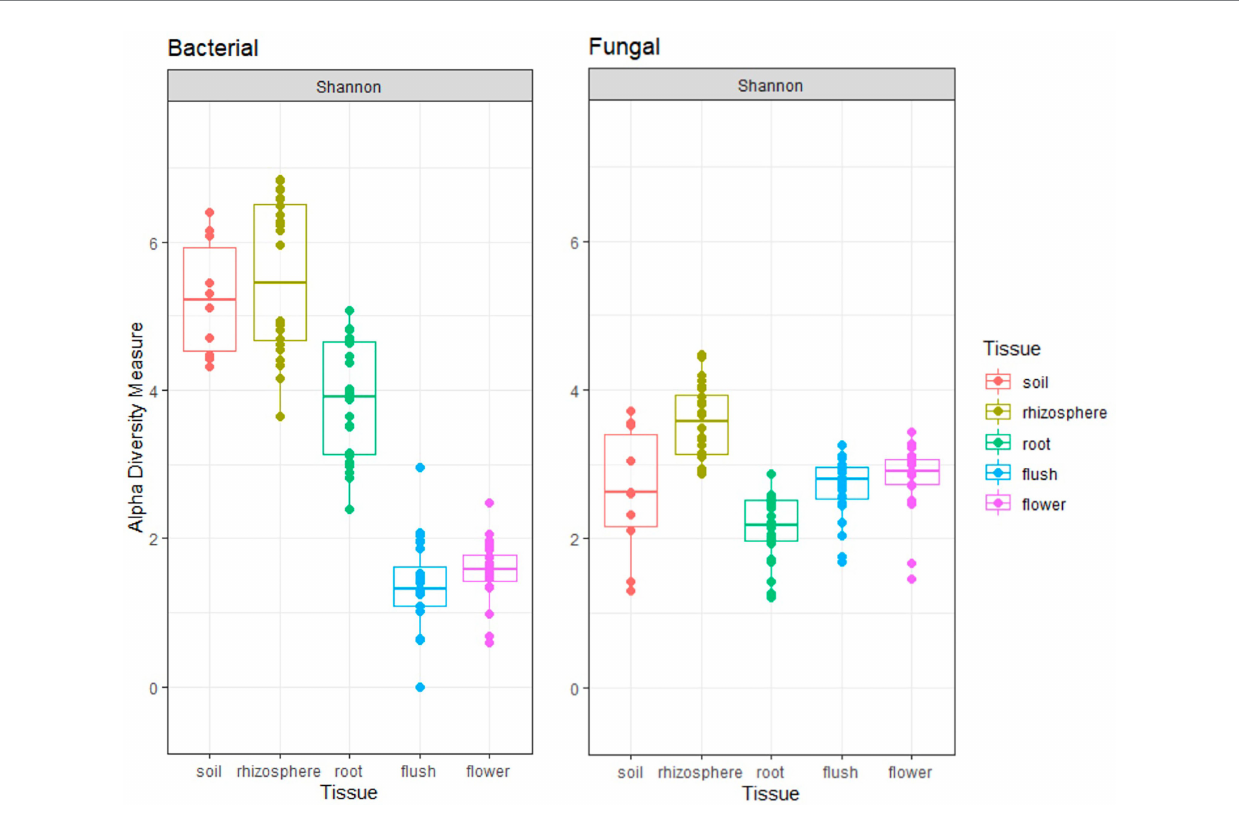
FIGURE 1 Shannon alpha-diversity plots indicate bacterial (left panel) and fungal (right panel) richness across five different citrus biocompartments (soil, rhizosphere, root, flush, and